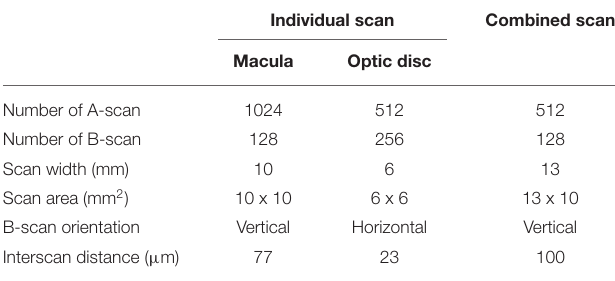
TABLE 1 | Specifications of the individual scan and combined scan